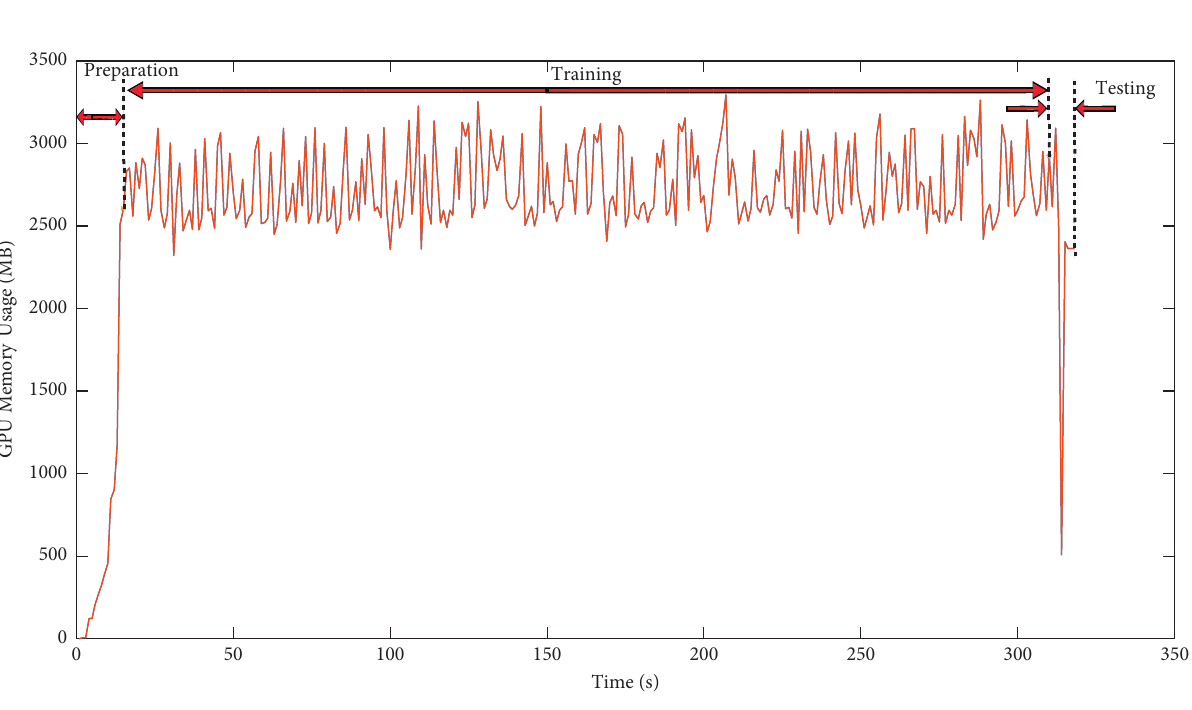
Figure 6: GPU usage trend.